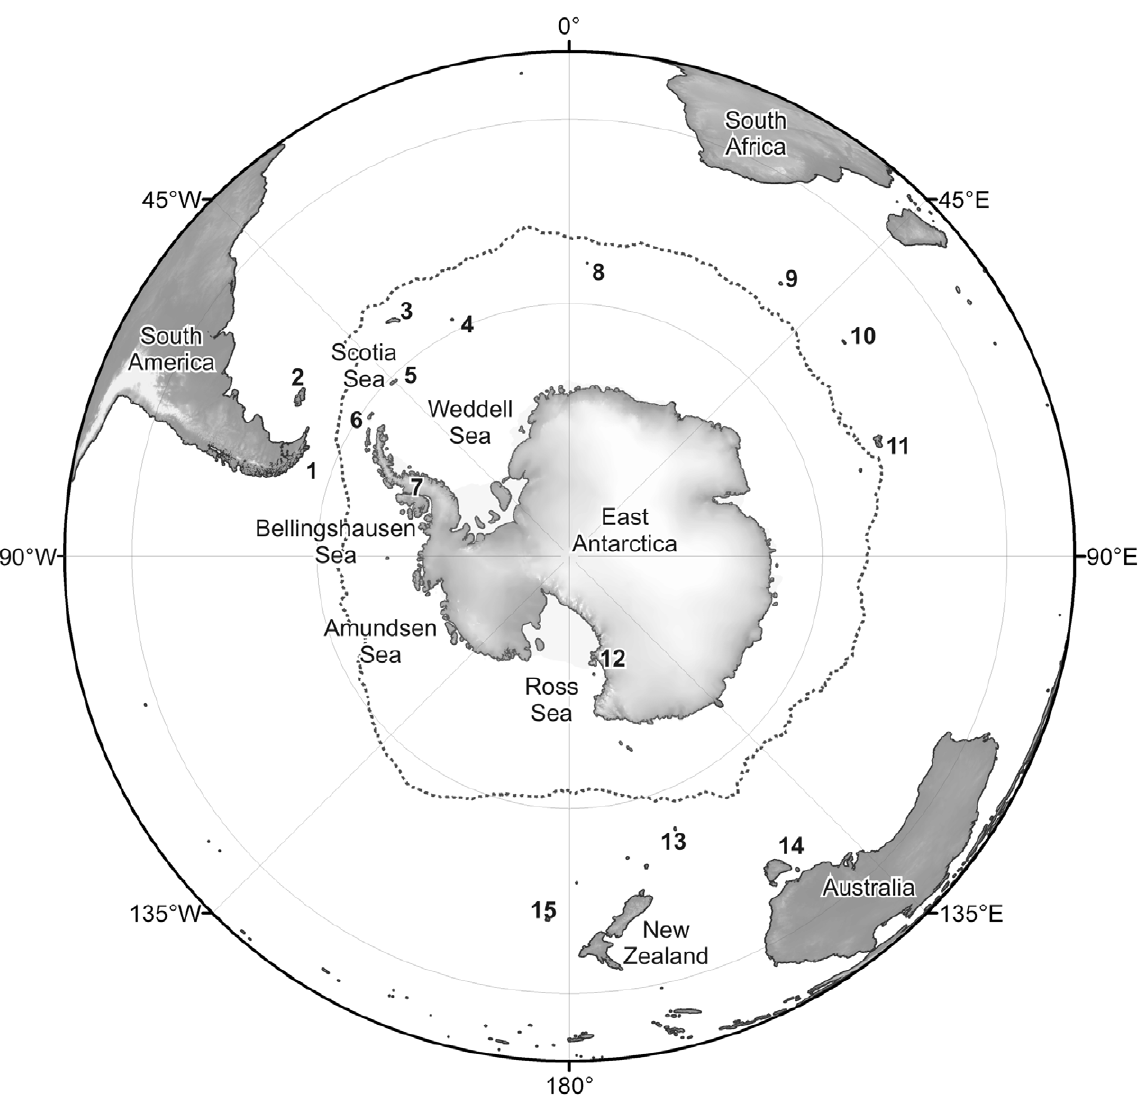
Figure 1. Map of the Southern Ocean and neighbouring regions. The dotted line around Antarctica represents the mean position of the PF. 1=Tierra del Fuego, 2=Falkland Islands, 3=South Georgia, 4=South Sandwich Islands, 5=South Orkney Islands, 6=South Shetland Islands, 7=Antarctic Peninsula, 8=Bouvet Island, 9=Prince Edward Islands, 10=Crozet Islands, 11=Kerguelen Islands, 12=McMurdo Sound, 13=Macquarie Island, 14=Tasmania, 15=Chatham Islands. (Figs. 5a–l, Table 2). Nearly half of the distribution patterns were represented by less than 10 species, with the remainder based on 10–53 species. All but one of the patterns observed were dominated by demosponge species ranging from 50 to 100% of the species. The species rich genera of Haliclona and Clathria (Demospongiae) were major contributors to many of the patterns.